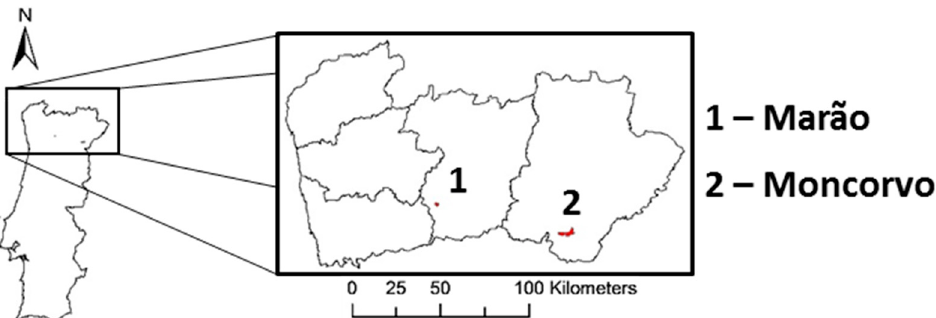
Figure 2. Identification of the origin in Portugal from magnetite and hematite minerals used for this experiment.